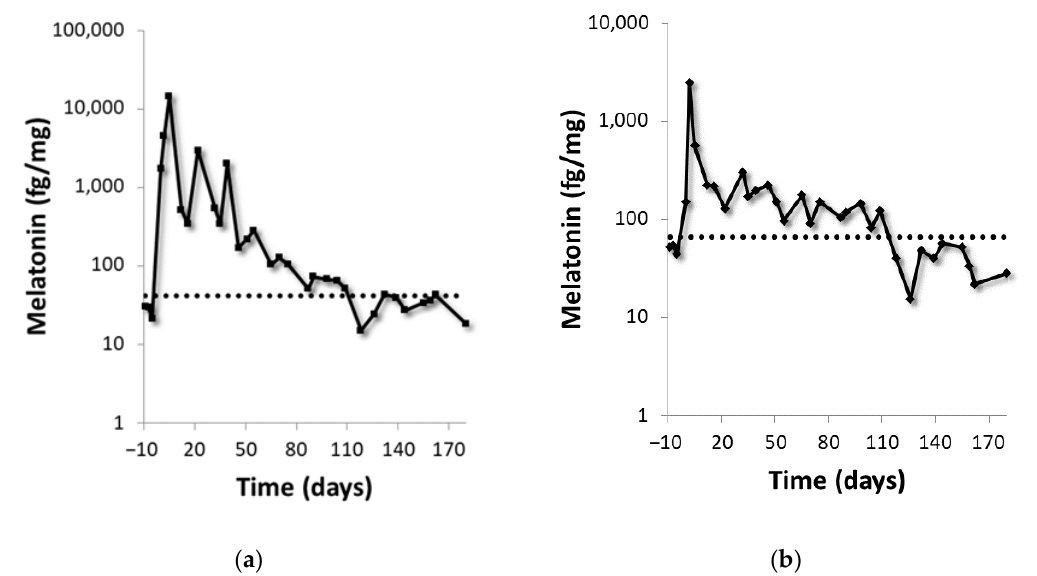
Figure 4. Nail melatonin content provides a weighted average of the circulating melatonin from the last 3.5 months. Changes over time in the nail’s melatonin levels (axis is represented in log scale) due to the exogenous administration of melatonin in the two volunteers: ( A ) male, ( B ) female. Dotted lines represent the endogenous levels for each volunteer calculated from basal samples (obtained between days − 10 and